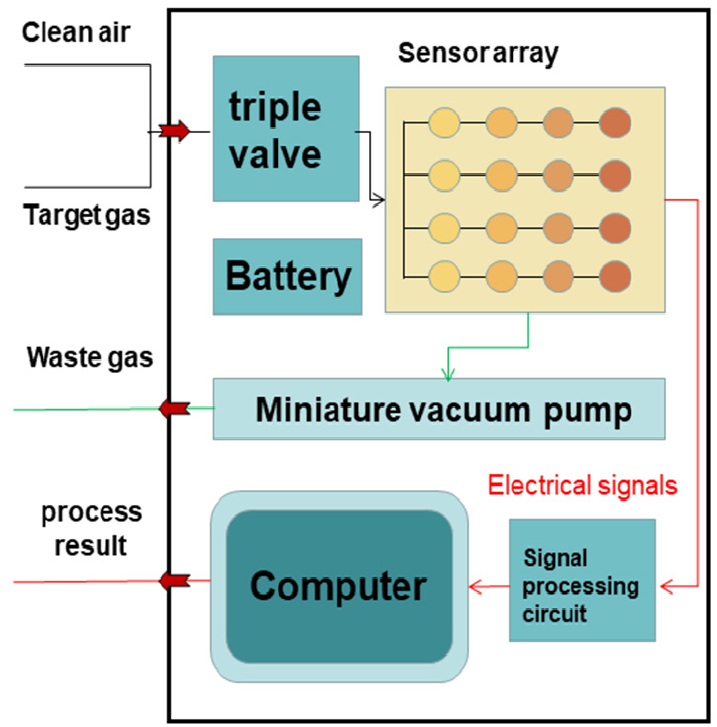
Figure 3. Electronic nose structure.